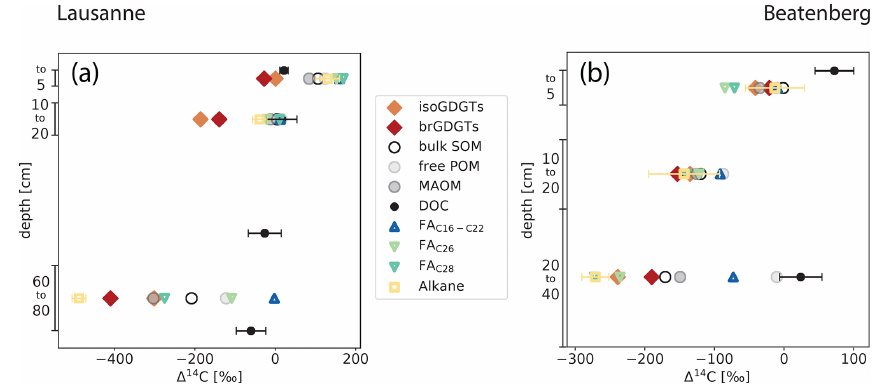
Figure 4. Radiocarbon content expressed as (cid:49) 14 C of organic matter fractions and compounds in Lausanne and Beatenberg soil profiles. In both soils (Lausanne – a ; Beatenberg – b ), the radiocarbon contents of both branched and isoprenoid GDGTs decrease to a similar degree to that of bulk SOM in each profile. The measured n -alkane in the Beatenberg soil is C 29 ; in the Lausanne soil the n -C 27 homologue was analyzed. Alkane, n -fatty acid (FA), free particulate organic matter (POM), mineral-associated organic matter (MAOM) and dissolved organic carbon (DOC) (cid:49) 14 C values are taken from Van der Voort et al. (2017). DOC was not measured in the same intervals as the other parameters but at 0, 15, 50 and 80cm and at 0 and 30cm depth in the Lausanne and Beatenberg soils, respectively. If error bars are not visible, then the uncertainty is smaller than the symbol